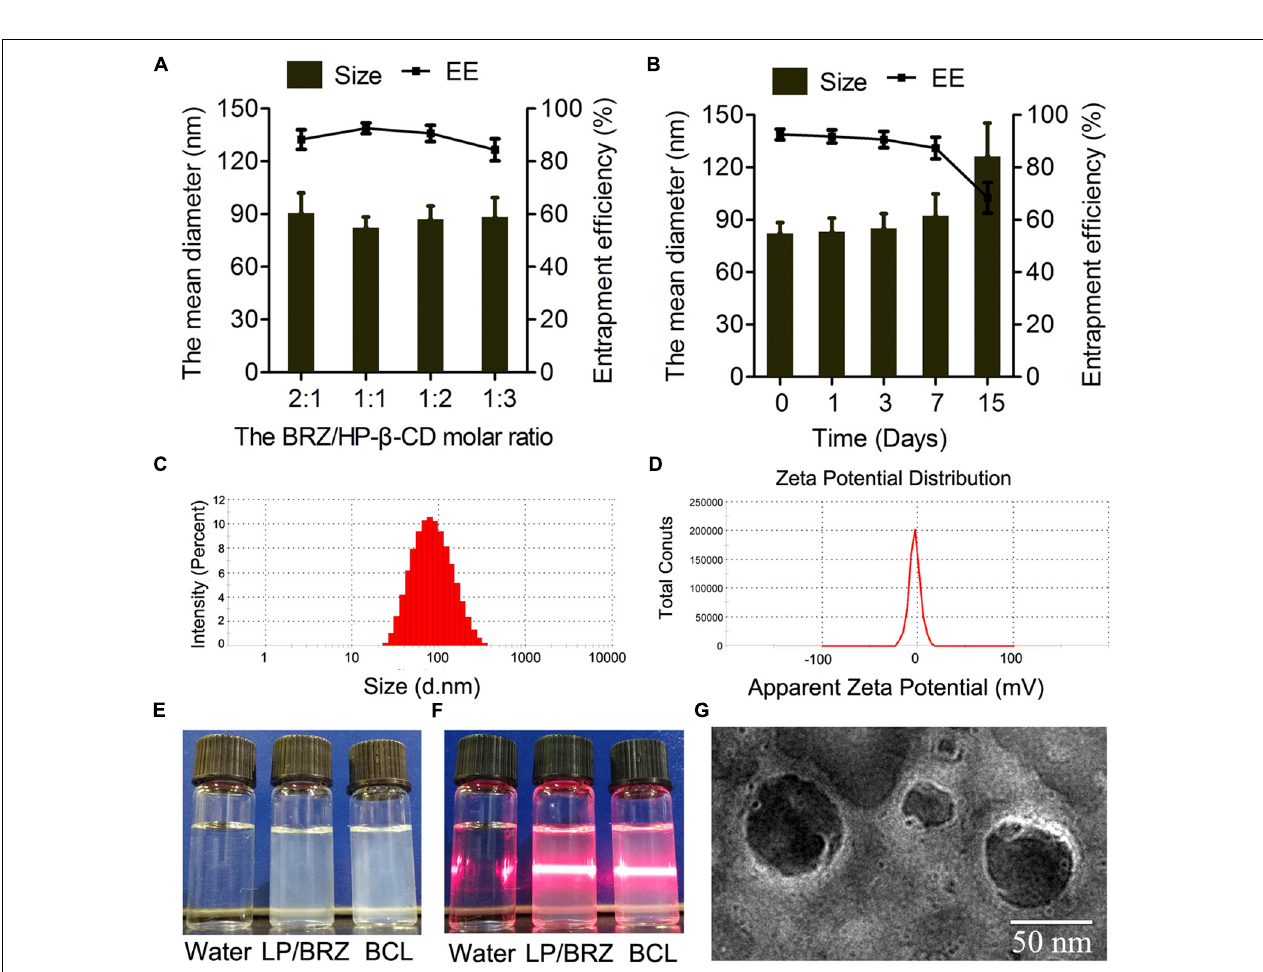
FIGURE 3 | Effects of various HP- β -CD/BRZ ratios on diameter and drug entrapment efficiency of BCL (A) ( n = 3). Change in size and entrapment efficiency of BCL at various time points stored at 4 ◦ C (B) ( n = 3). Size distribution (C) , ζ potential (D) , appearance (E) , and tyndall effect (F) of BCL. TEM images of BCL (G) .